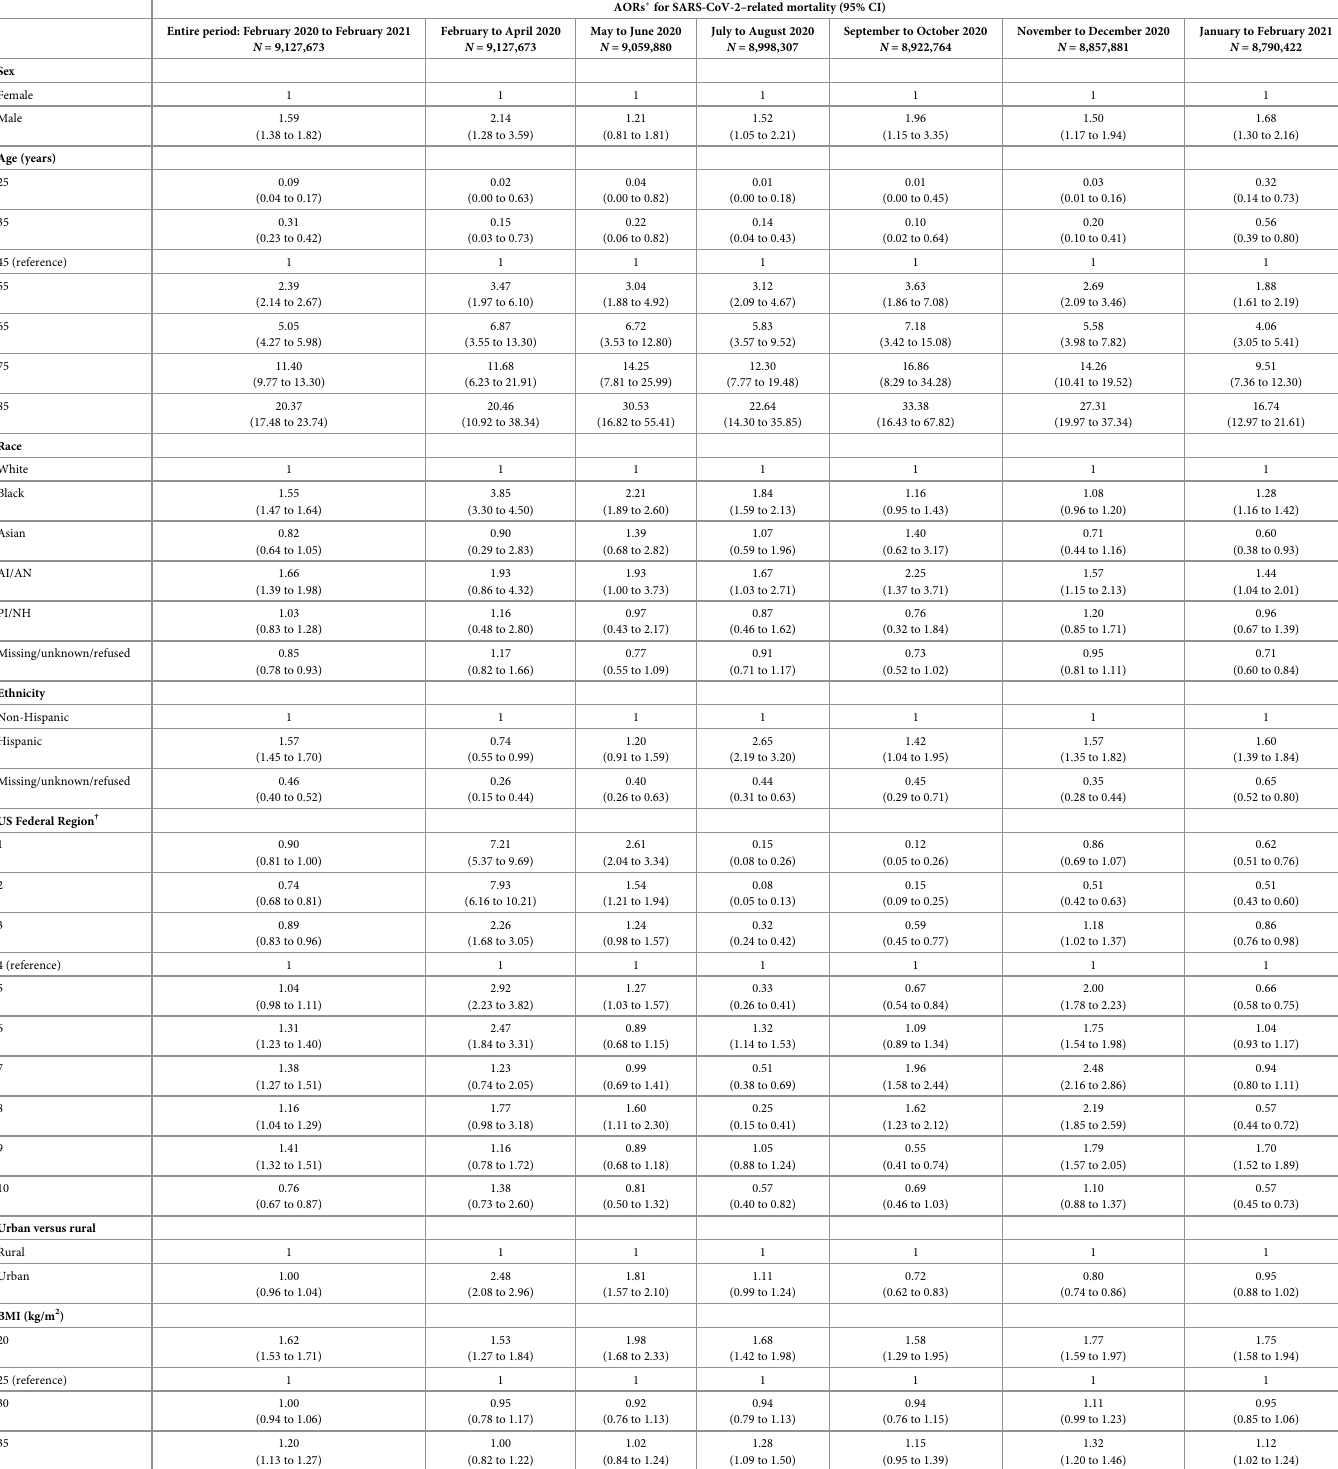
Table 4. Trends over time in the associations (AORs � ) of sociodemographic characteristics and comorbidity burden with risk of SARS-CoV-2–related mortality in a cohort of 9.1 million VA enrollees from February 2020 to February